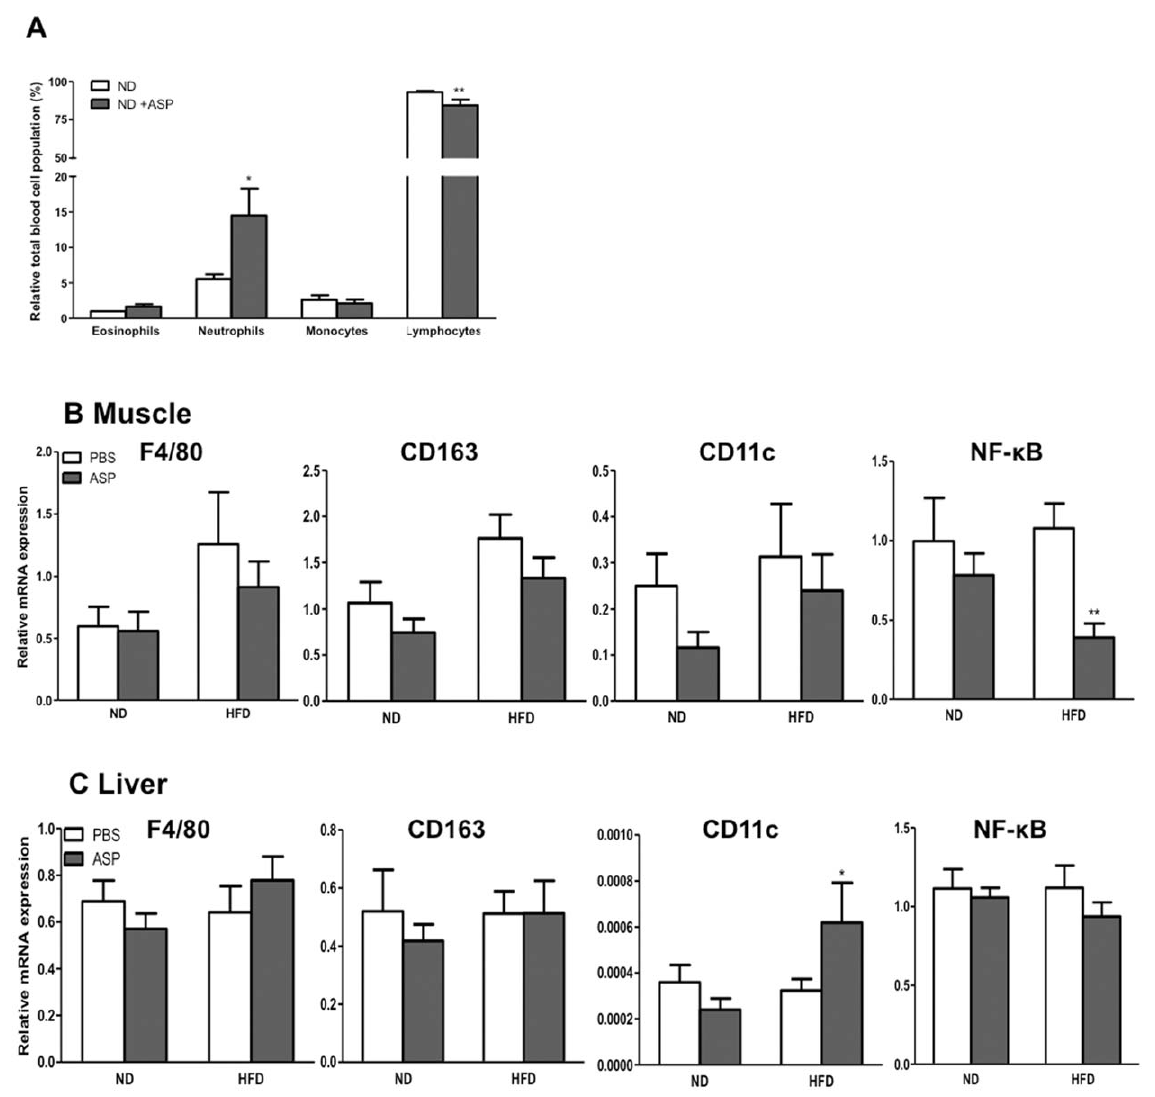
Figure 5. ASP effects on circulating immune cells and mRNA of immune-related genes in muscle and liver. A) Circulating immune cell distribution in C3KO 6 ASP administration on ND. B and C) Gene expression in muscle (B) and liver (C) of immune-related genes in C3KO 6 ASP on ND and HFD. Results are presented as average 6 SEM (n=5–8), where *p , 0.05, **p , 0.01 and ***p , 0.001.